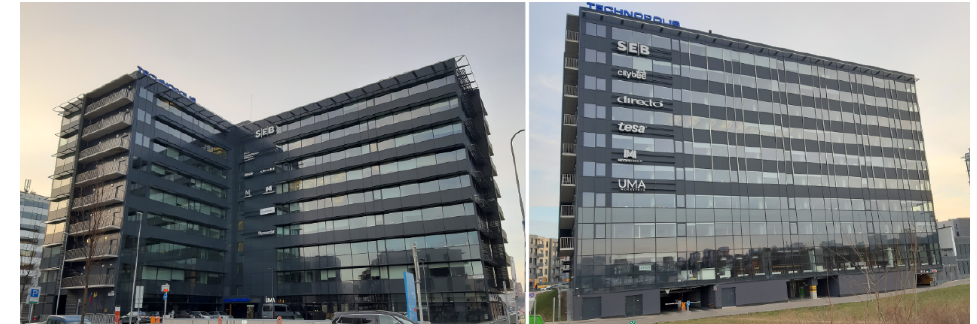
Figure 1. Analysed building facades.